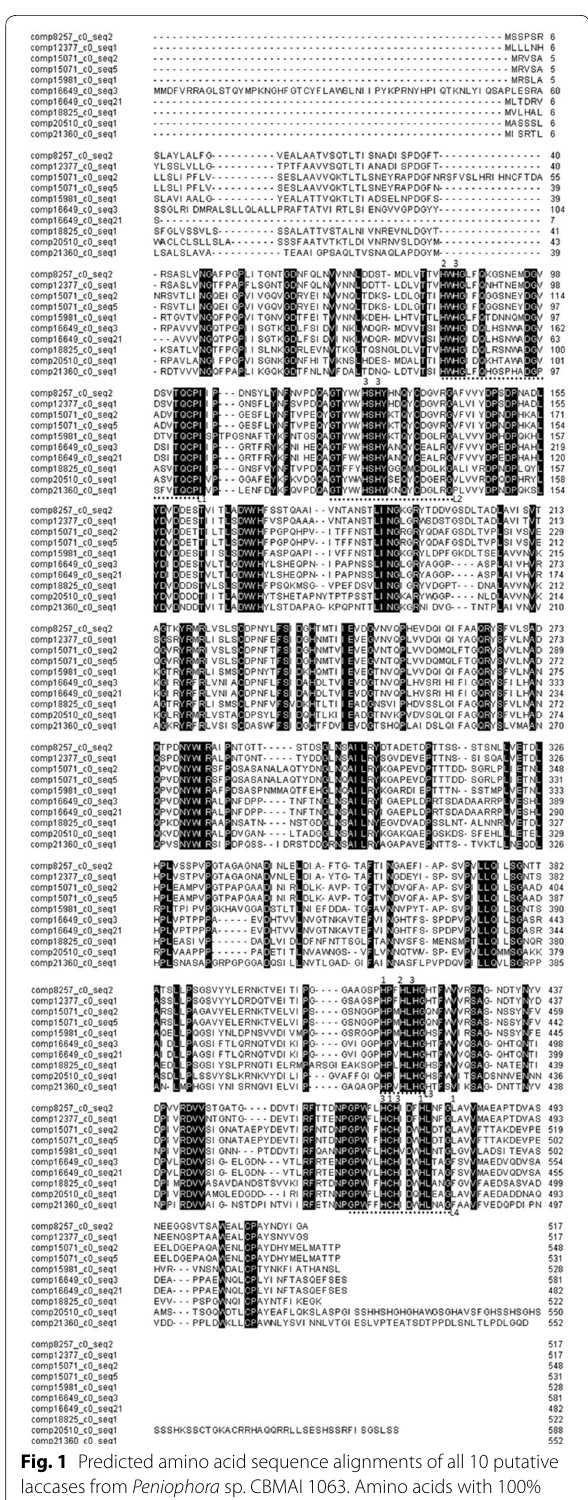
Fig. 1 Predicted amino acid sequence alignments of all 10 putative laccases from Peniophora sp. CBMAI 1063. Amino acids with 100% matches are highlighted in black. Numbers above the amino acids indicate that they are copper ion-bound. Dots below the amino acids indicate conserved regions in the fungal laccases (L1, L2, L3 and